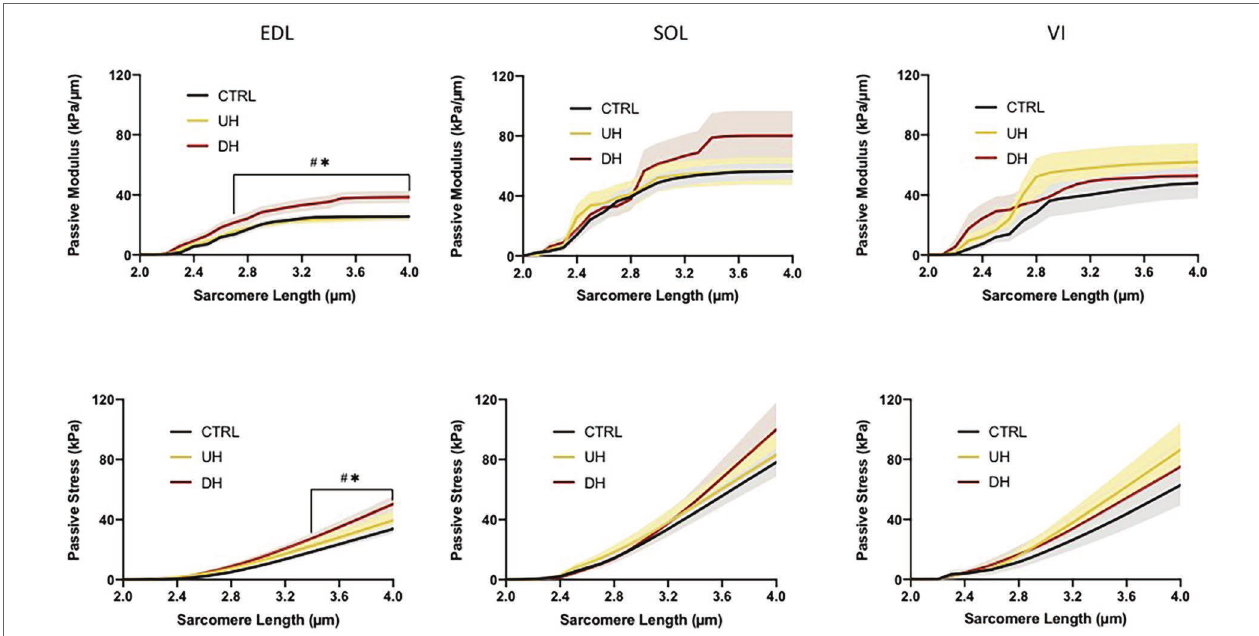
FIGURE 3 | Mean (solid lines) and SEM (shaded) muscle fiber bundle passive elastic modulus (top panel) and stress (bottom panel) for each muscle (EDL, SOL, and VI) across the range of SLs. * indicates statistical difference between DH and uphill (UH) groups. # indicates statistical difference between CTRL and DH groups. ( n = 179; p < 0.05).